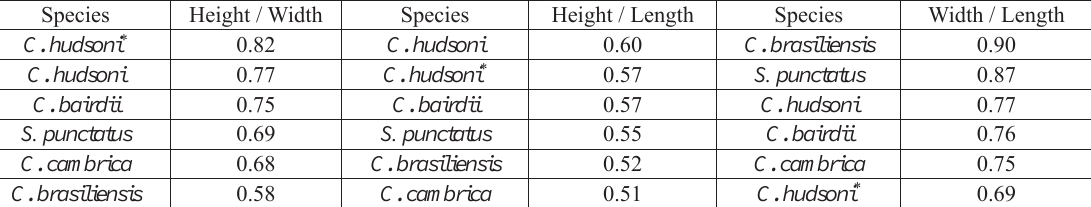
Table 4. Skull dimensional ratios for Clevosaurus and Sphenodon , with specimens shown in sequence of values for each. Clevosaurus hudsoni , NHMUK PV R36832 (Fig. 12A); C. hudsoni * (from Fraser 1988: fig. 3); C. cambrica , NHMUK PV R37014 (Fig. 12B); C. bairdii (from Sues et al. 1994: fig. 5); C. brasiliensis (from Bonaparte and Sues 2006: fig. 2); Sphenodon punctatus (from Maisano 2001). Skull width is the highest value measured across the jugals, skull height is the highest point of the skull around the region of the coronoid, and skull length is measured from the premaxillae to the